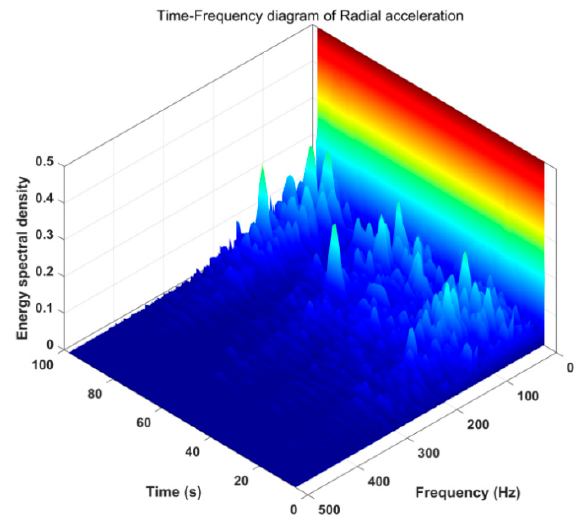
Figure 16. Time-frequency diagram of radial acceleration of whirl. Figure 16. Time ‐ frequency diagram of radial acceleration of whirl. Figure 16. Time ‐ frequency diagram of radial acceleration of whirl.